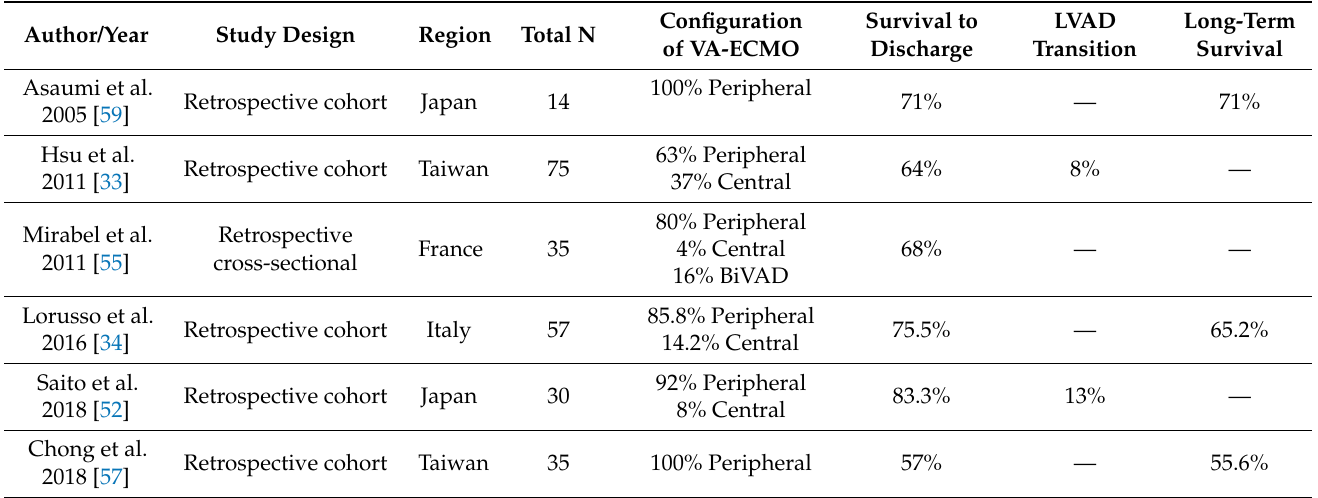
Table 2. Survival rates fulminant myocarditis patients on